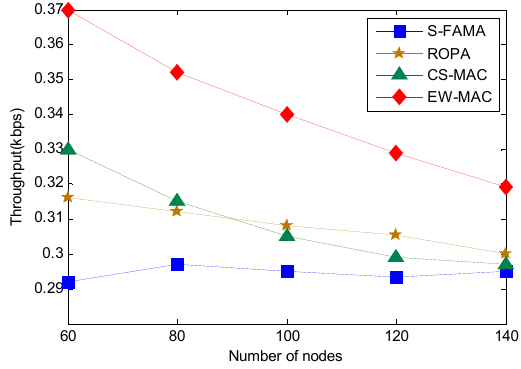
Figure 7. Throughput at different network sensor densities.